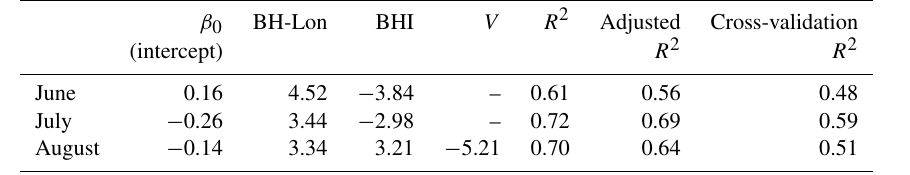
Table 1. Regression coefficients and coefficients of determination ( R 2 ) of the best-fit MLR models for June, July, and August. The model cross-validation R 2 is shown in the last column.